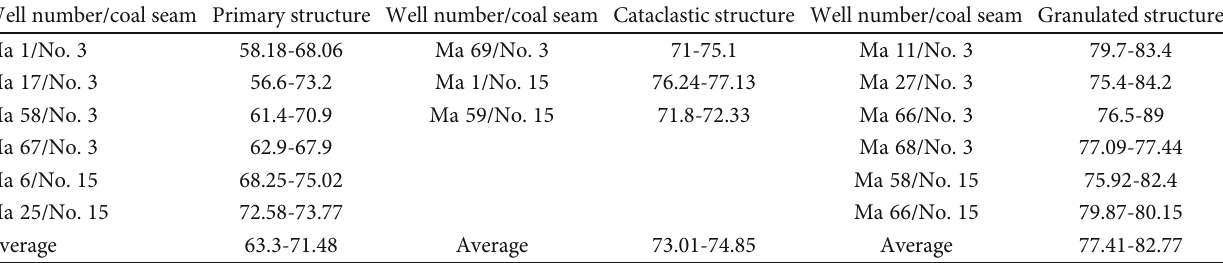
Table 2: Coal brittleness index seams with di ff erent coal-body structures in the Mabidong block. Well number/coal seam Primary structure Well number/coal seam Cataclastic structure Well number/coal seam Granulated structure Ma 1/No.